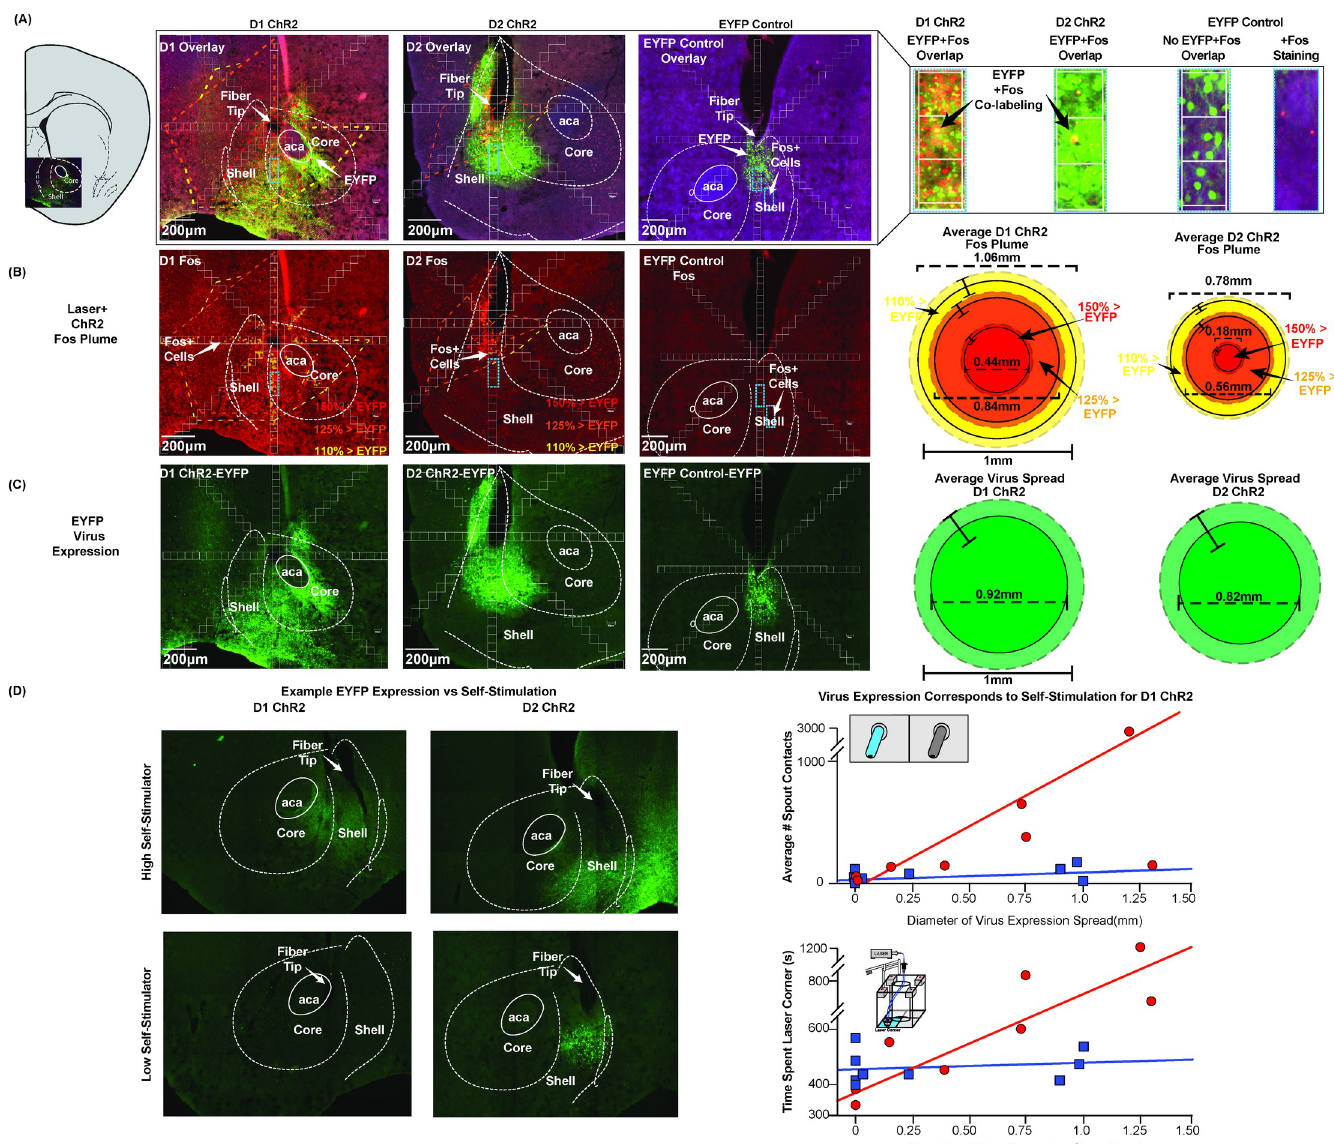
Fig 5. Laser-induced Fos plumes and virus expression in NAc. Top (A): Overlay of immunohistochemistry-labeled Fos protein expression (AlexaFluor488; red), virus expression (enhanced yellow florescent protein; EYFP; green), and calculated Fos plume boundaries (% Fos elevation induced by laser + ChR2 over EYFP baselines). Blue outlined insets show close-up 50um square boxes used to count neurons with Fos expression, and to assess viral spread within radial arms. ChR2 or EYFP-control mice here all received laser stimulations immediately before euthanasia. (B) Fos examples from D1 mice are in left column; D2 mice are in the middle; EYFP control mice are in right column after receiving laser stimulation. Squares (50 μ m x 50 μ m) emanate along radial arms from the center of the fiber tip. Individual plume boundaries assessed by different intensities of laser+ChR2 Fos elevation above EYFP control baselines ( > 110%; > 125%; > 150% indicated by colors of dashed lines). Mean diameters of Fos plume intensity zones are shown right. D1 ChR2 stimulation produced a 0.44mm (SEM ± 0.050) inner plume reaching 150% elevation of Fos above EYFP control, with a larger 0.84mm (SEM ± 0.065) diameter middle plume of > 120% elevation of Fos, surrounded by an even larger 1.06mm (SEM ± 0.037) diameter outer plume of > 110% elevation. D2 ChR2 plumes had lower intensity centers of > 150% Fos elevation with 0.18mm diameter (SEM ± 0.029), a 0.58mm (SEM ± 0.049) diameter middle plume of > 120% enhancement, and an outer 0.78mm plume (SEM ± 0.036) of > 110% Fos enhancement. (C) Virus spread alone: D1 mean diameter of 0.92mm (SEM ± 026mm), and D2 diameter of 0.82mm (SEM ± 0. 22mm). (D) (Left) Example images of the highest self- and lowest stimulating D1 or D2 ChR2 mice. (Right) Virus expression correlates with D1 ChR2 mouse self-stimulation on both spout-tasks and location-based stimulation, but not for D2 ChR2. https://doi.org/10.1371/journal.pone.0207694.g005 virus diameters of 0.82mm (SEM+/- 0.26mm) (D1 ChR2 vs D2 ChR2 Viral Spread Kruskal Wallis, X 2 = 0.145, p = .703). However, a few D1 ChR2 and D2 ChR2 individuals had larger